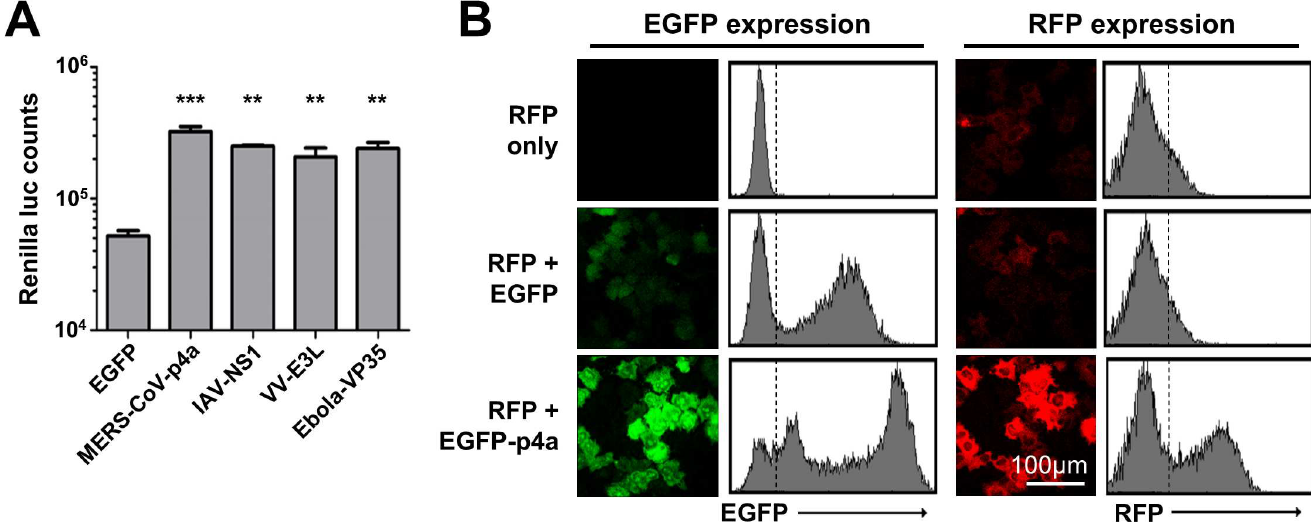
Fig 3. MERS-CoV p4a rescues protein translation upon plasmid DNA transfection-mediated stress. (A) Bar-graph showingRenillaluciferase counts measured at 16h post co-transfection of pTK-RLuc and pEGFP expressionplasmids. Means and standard deviationsare shown of triplicate measurements. Data was analyzedusing an unpaired t-test ( *** , p < 0.001; ** , p < 0.01). (B) Flow cytometry analysisof HeLa cells expressing RFP, RFP and EGFP, or RFP and EGFP-p4a. The dashed lines in the histograms divide non-RFP/EGFP expressing cells from RFP/EGFP-expressing